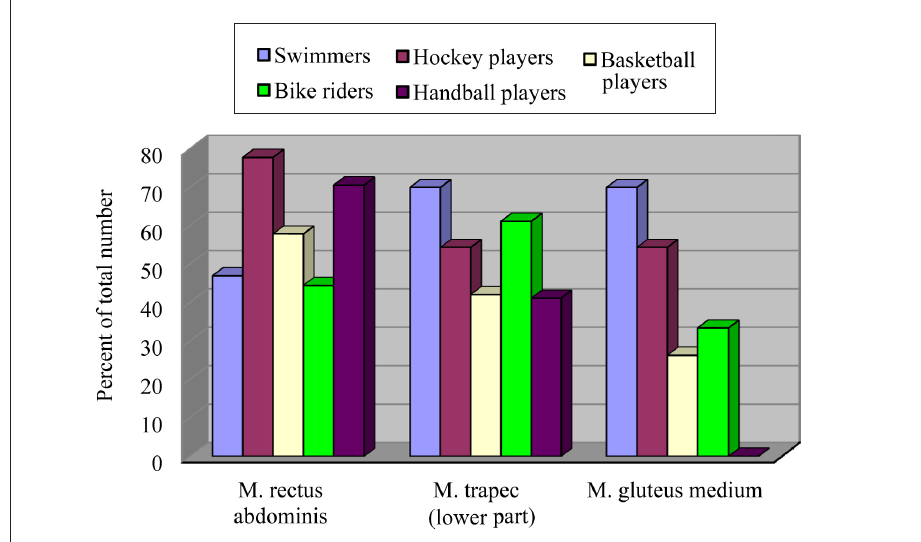
Figure 4. Results of swim-